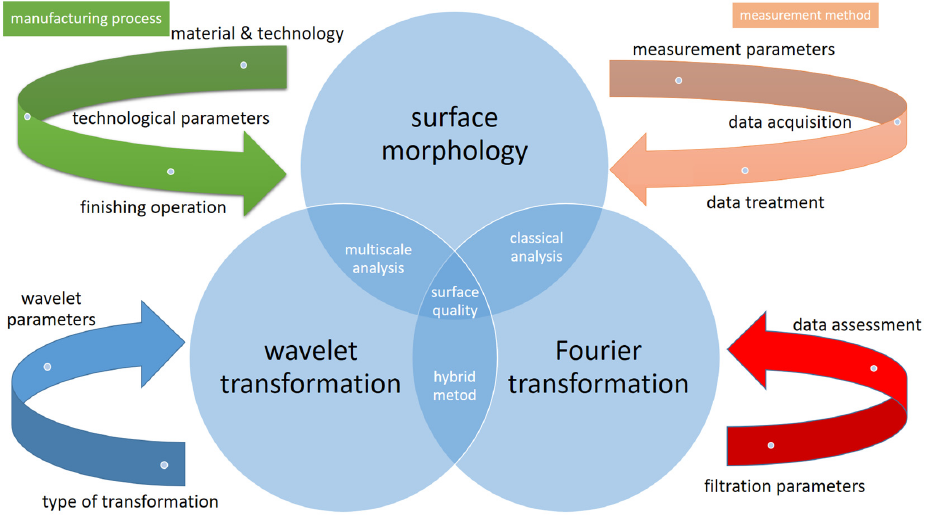
Figure 1. Relationship between surface morphology and methods for analyzing measurement data.